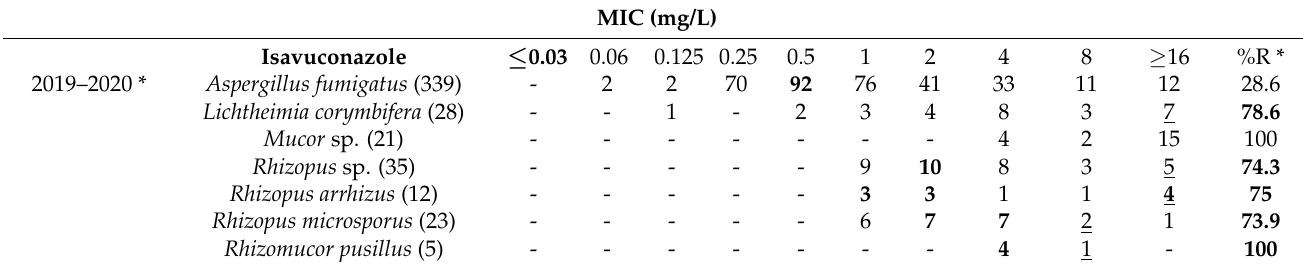
Table 5. MIC distributions for isavuconazole. For presentation conventions, see Legend to Table 2. Since isavuconazole testing was not employed prior to 2017, historical data for A. fumigatus isolates for the period 2006–2016 is not available for comparison.